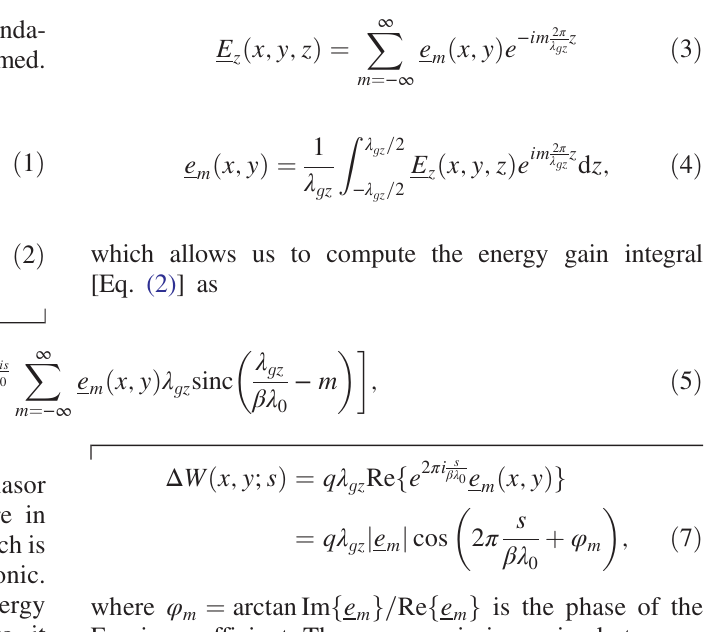
FIG. 3. One period of a symmetric Bragg mirror cavity structure.